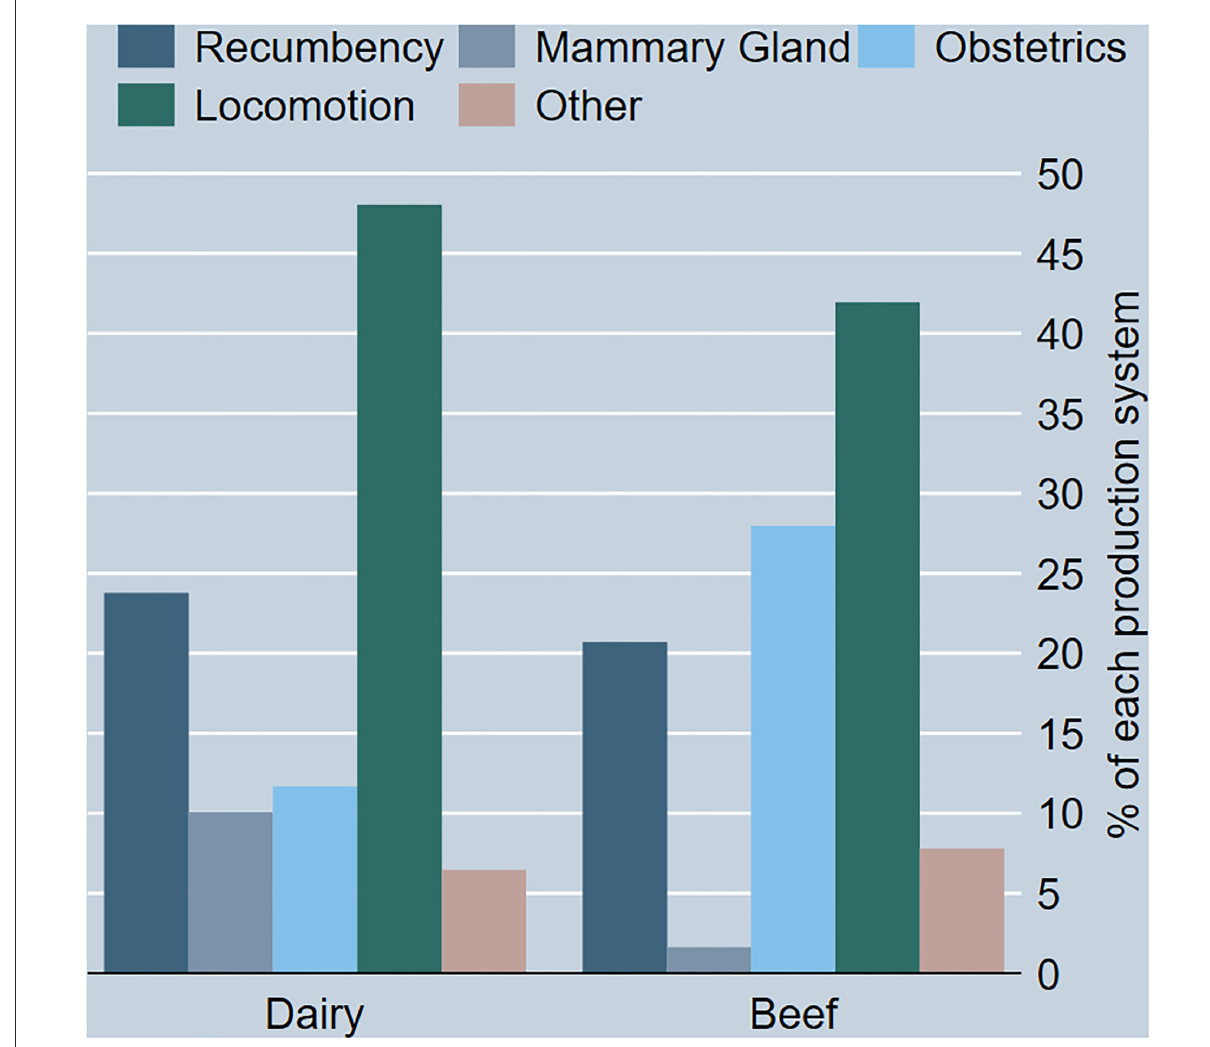
FIGURE1 Bar graph showing the proportion of each reason for OFES for the two production systems n =